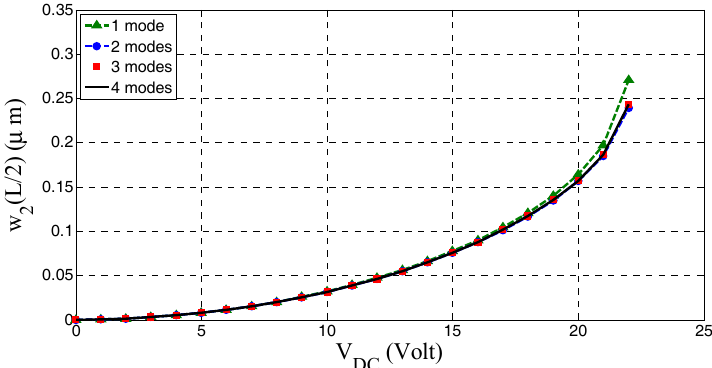
Figure 2. Convergence of the upper microbeam maximum static deflection assuming the case study of Table 1. Table 1 . Selected case study of a double-microbeams based actuator.